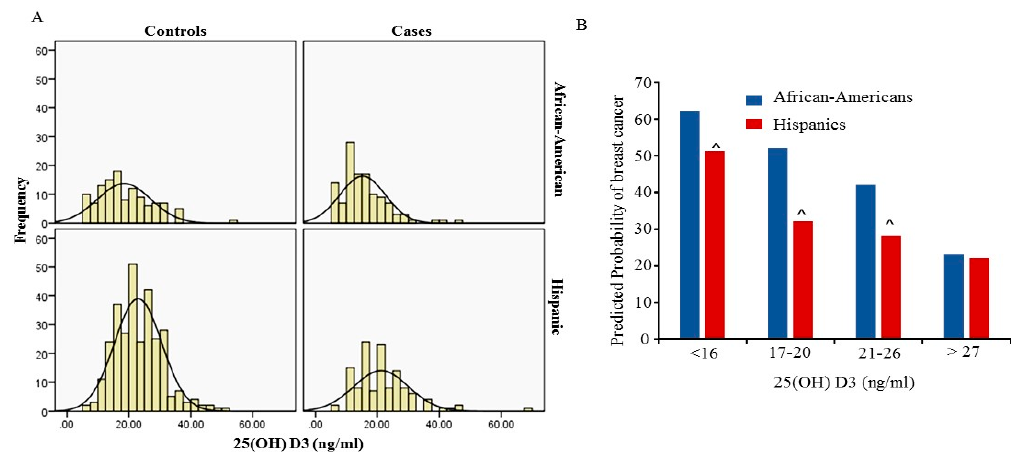
Figure 1. Serum 25 (OH)D3 level and its association with breast cancer in African-American and Hispanic women. ( A ) the bar graphs demonstrates the distribution of serum 25(OH)D3 levels between case and control groups in African-Americans and Hispanics as indicated; ( B ) Probability of breast cancer by serum 25(OH)D3 in different percentiles was predicted by Logistic regression utilizing IBM SPSS version 22, blue bar indicates the probability in African-Americans and red bar indicates the probability in Hispanics. ^ p < 0.05 indicates the probability of breast cancer compared to African-Americans in the indicated range of 25(OH)D3 level.